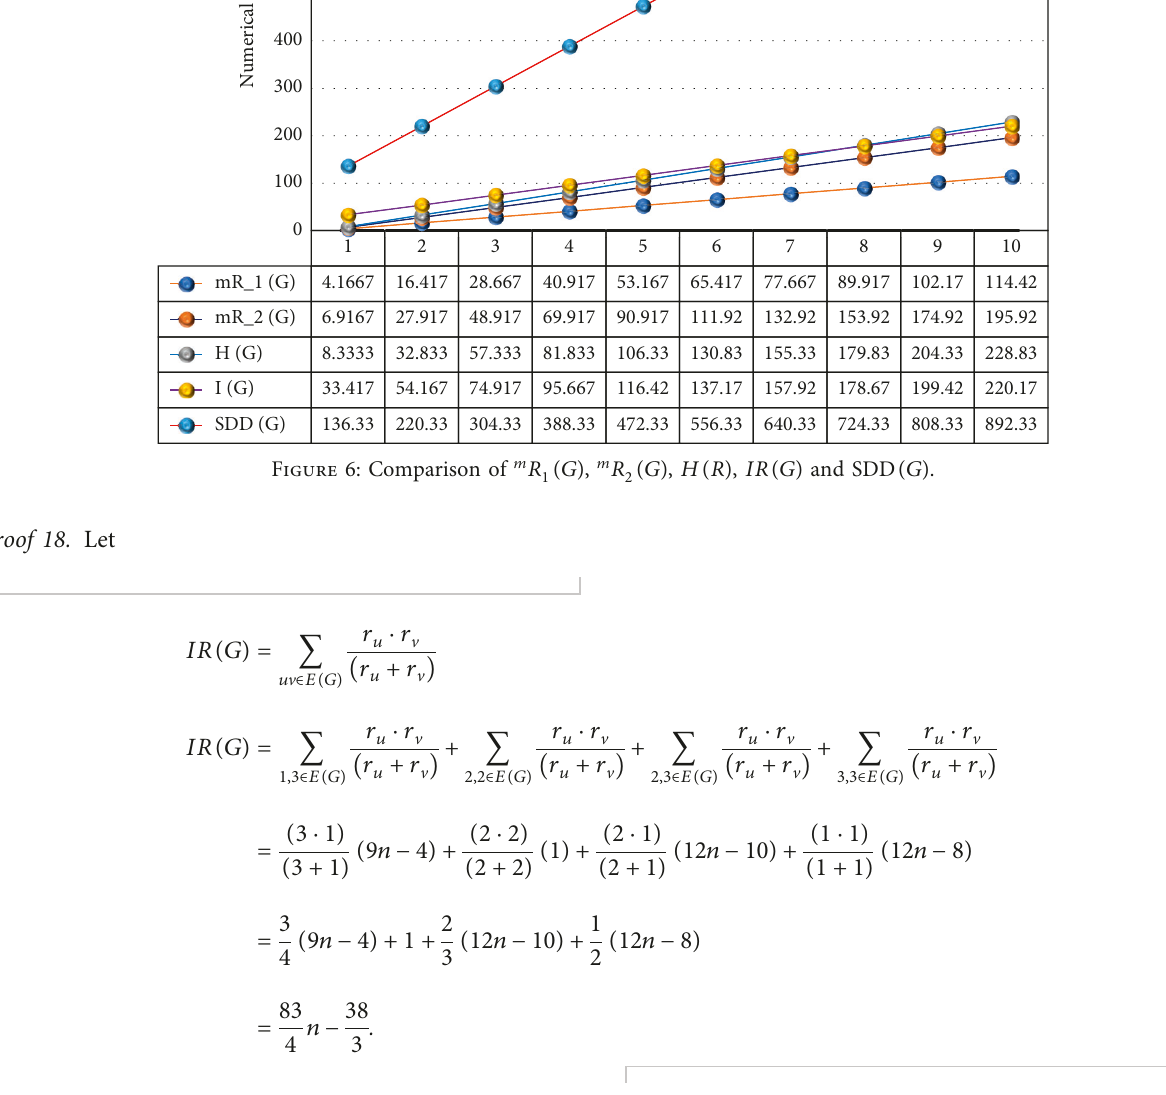
Figure 6: Comparison of m R